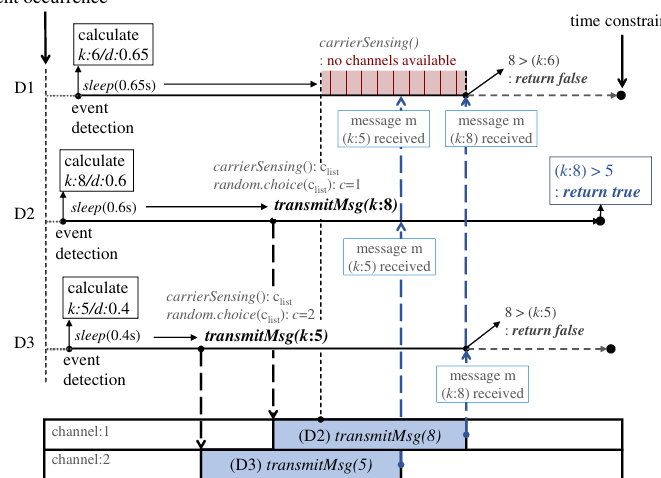
Figure 6. System flow example: As shown in the left figure of Figure 4b, upon an external event occurrence in a room, devices D1, D2 and D3 all detect it simultaneously and independently, and thus the dotted circle denotes the area in which the event can be reached and confines the ephemeral group members. This example assumes two channels. Then, each member device individually follows the steps of the supported framework, as explained in Section